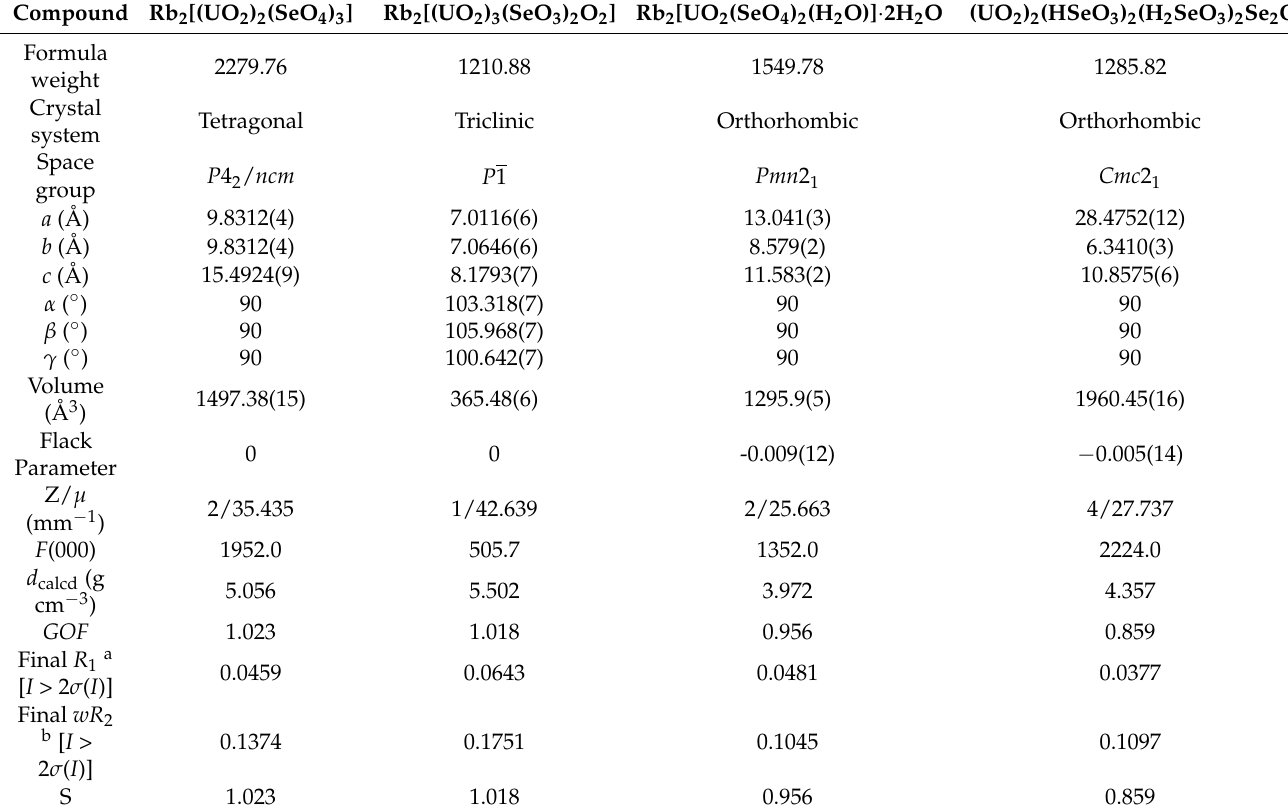
Table 1. Crystallographic data for all phases reported in this